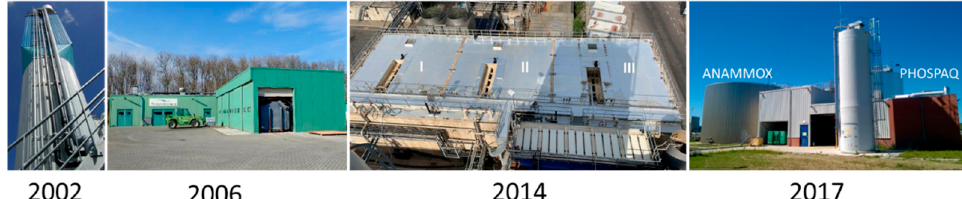
Figure 1. Photographs of various ANAMMOX reactor installations constructed in time (left to right): Rotterdam (2002): biosolids reject; Olburgen (2006): biosolids reject + food industry (PN/A reactor + Phospaq struvite reactor); Son (2014): Industrial effluent and Tilburg (2017): THP-biosolids reject (PN/A + Phospaq struvite reactor).